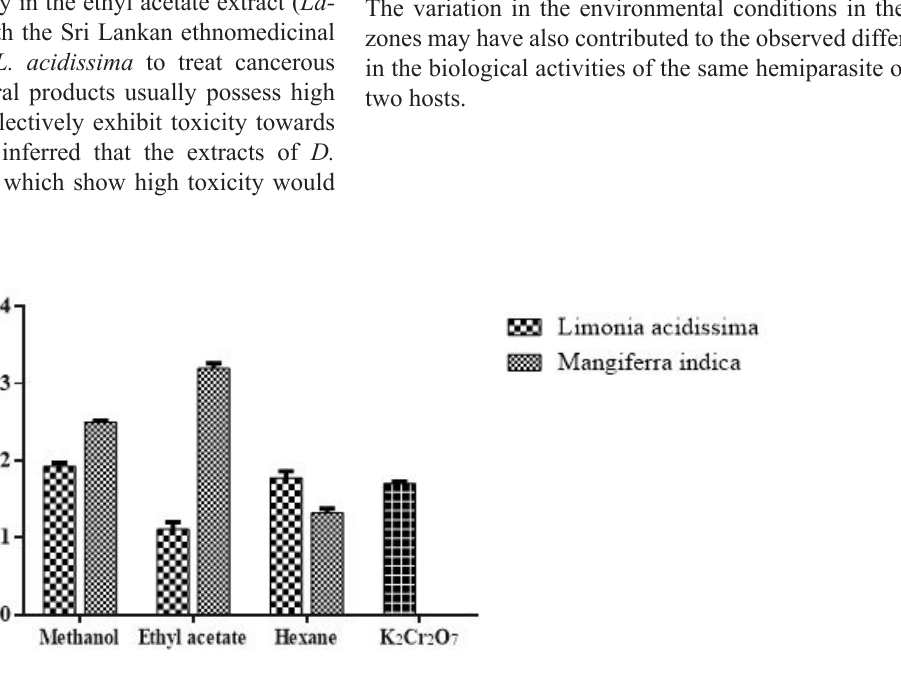
values of brine shrimp lethality of the extracts of D. falcata Figure 3: Variation of the LC 50